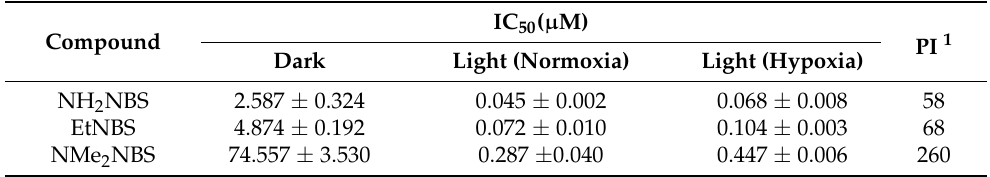
Table 1. Phototoxicity and dark toxicity of NH 2 NBS, EtNBS, and NMe 2 NBS against HepG2 cancer